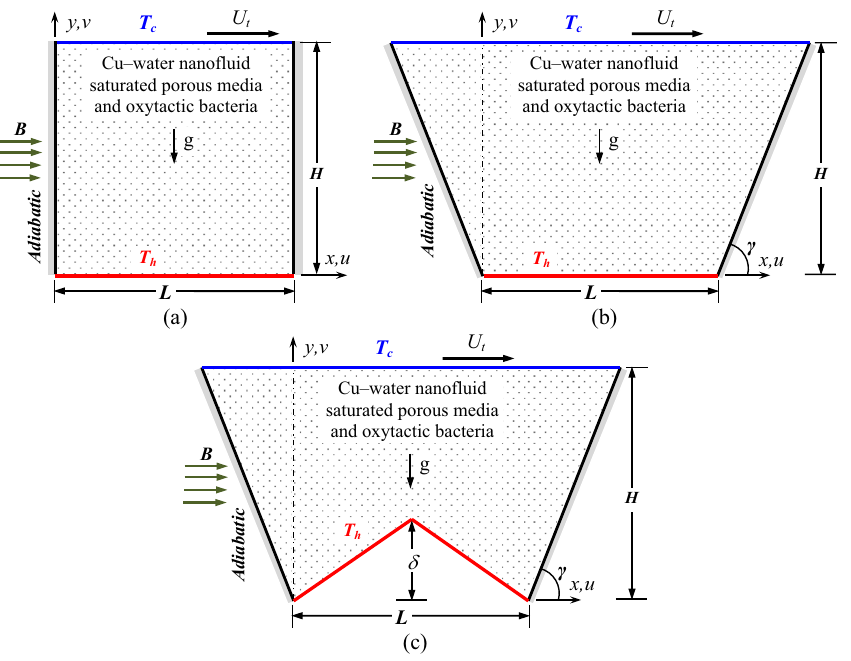
Figure 1. Schematics of the problem geometry including boundary conditions with ( a ) square cavity, ( b ) trapezoidal cavity, and ( c ) W-shaped